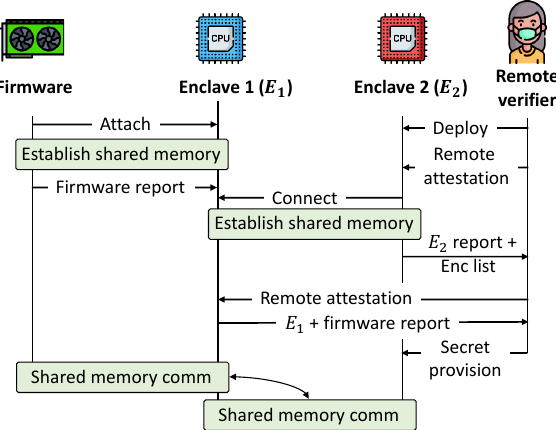
Figure 3: Flow of the remote attestation process between the user and a composite enclave that consists of E 1 , E 2 and the